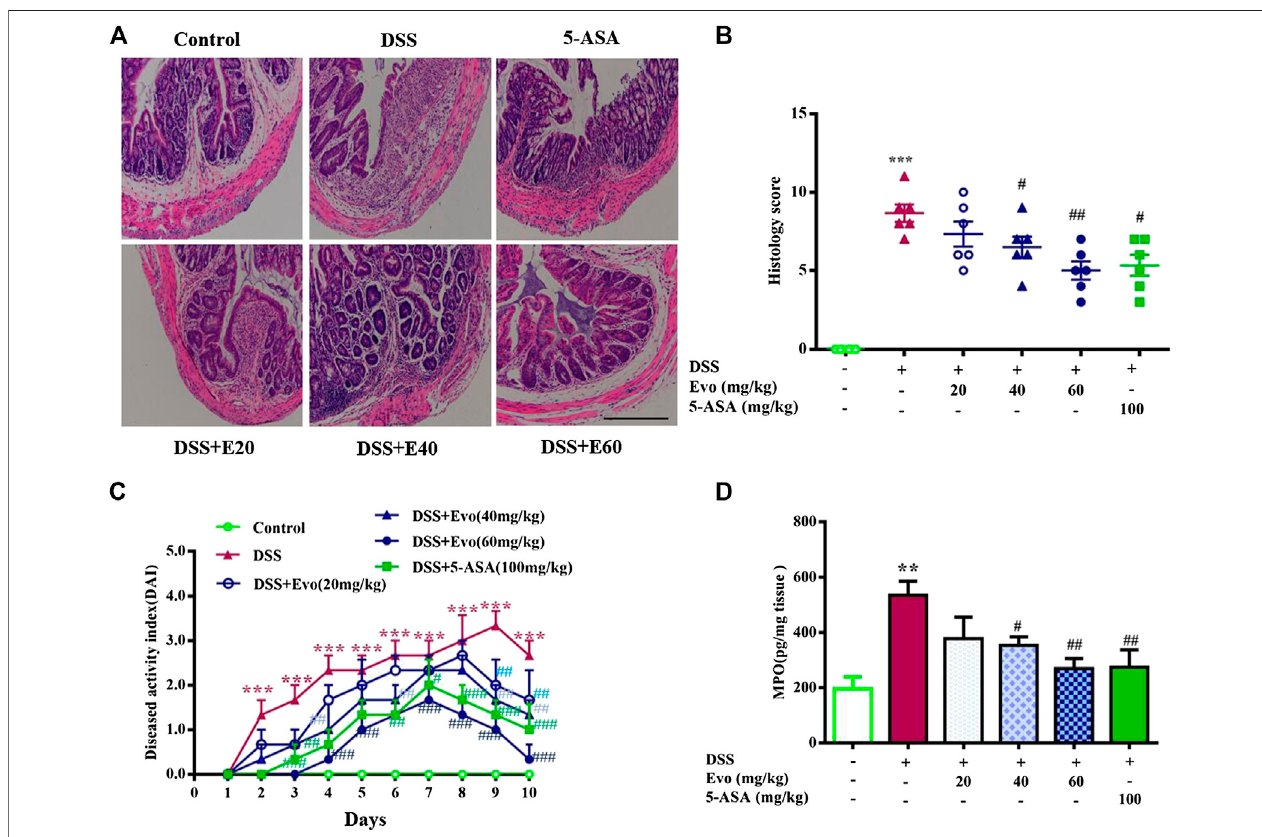
FIGURE 2 | Evodiamine ameliorated colonic pathological damage in experimental ulcer colitis mice. (A) Paraf fi n-embedded colon sections were stained with H&E for assessment of epithelial damage. Original magni fi cation 100 × . (B) Histology score. (C) Disease activity index (DAI) scores were evaluated daily. (D) MPO level in colonic tissues. Data are presented as mean ± SE ( n (cid:2) 6 for each group). * p < 0.05, ** p < 0.01, and *** p < 0.001 compared with the control, # p < 0.05, ## p < 0.01, and ### p < 0.001 compared with the DSS group.